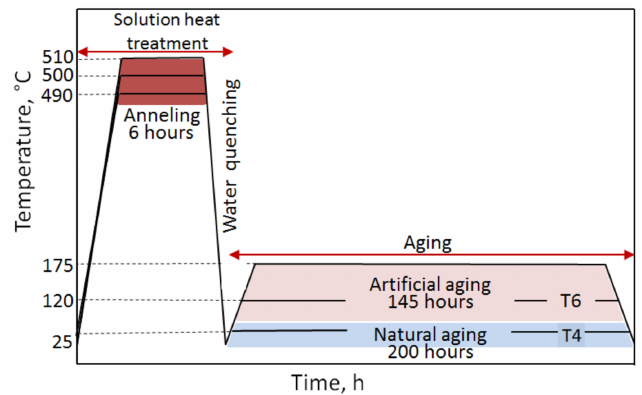
Figure 3. Diagram presenting heat treatment of the 2017A aluminium